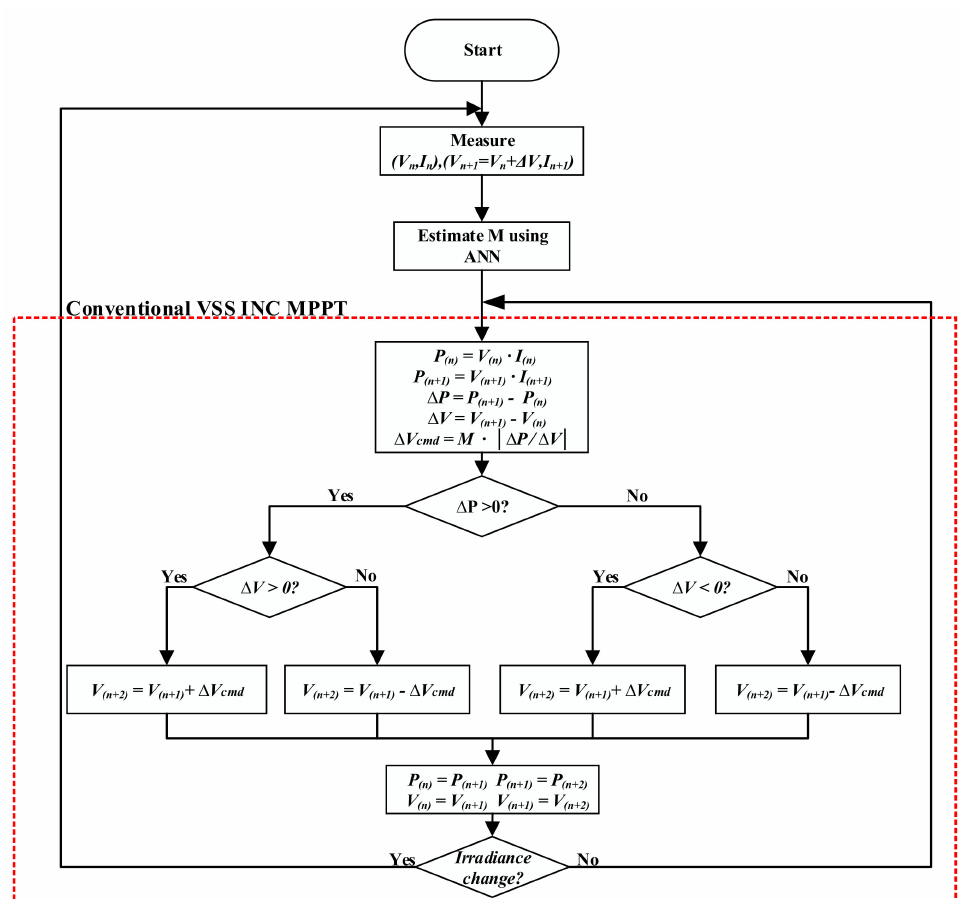
Figure 5. Flow chart of the proposed ANN-assisted VSS IncCond MPPT